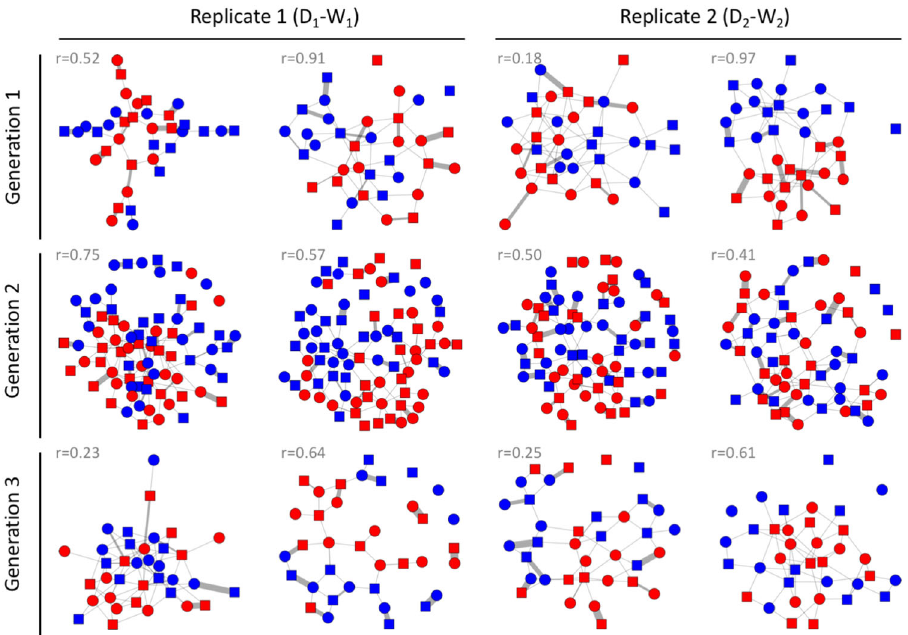
Fig. 1 Social networks of all experimental groups across three generations. Each network depicts one aviary with equal numbers of males and females from different backgrounds (as shown in Fig. 3). Symbols (nodes) represent individual males (squares) and females (circles). Lines between the nodes (links) represent the number of associations re fl ecting pair bonding (allopreening, sitting in bodily contact, and visiting a nest box together). Colours represent the cultural background: domesticated (D, red) and wild-derived (W, blue). The r -values are the assortativity coef fi cients (a network version of the Pearson ’ s correlation coef fi cient) with regard to cultural background (see Supplementary Table 3 for details). Group sizes are 36 in Generations 1 and 3, and 80 in Generation 2 (except for one aviary with only 32 males and 31